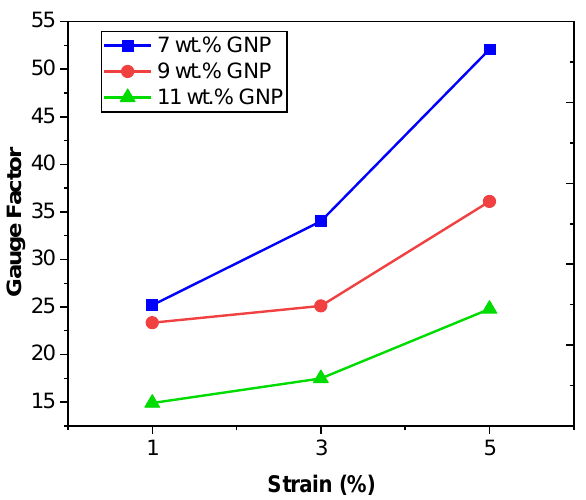
Figure 6. GF values calculated for the cycling test as a function of the strain level and GNP content.